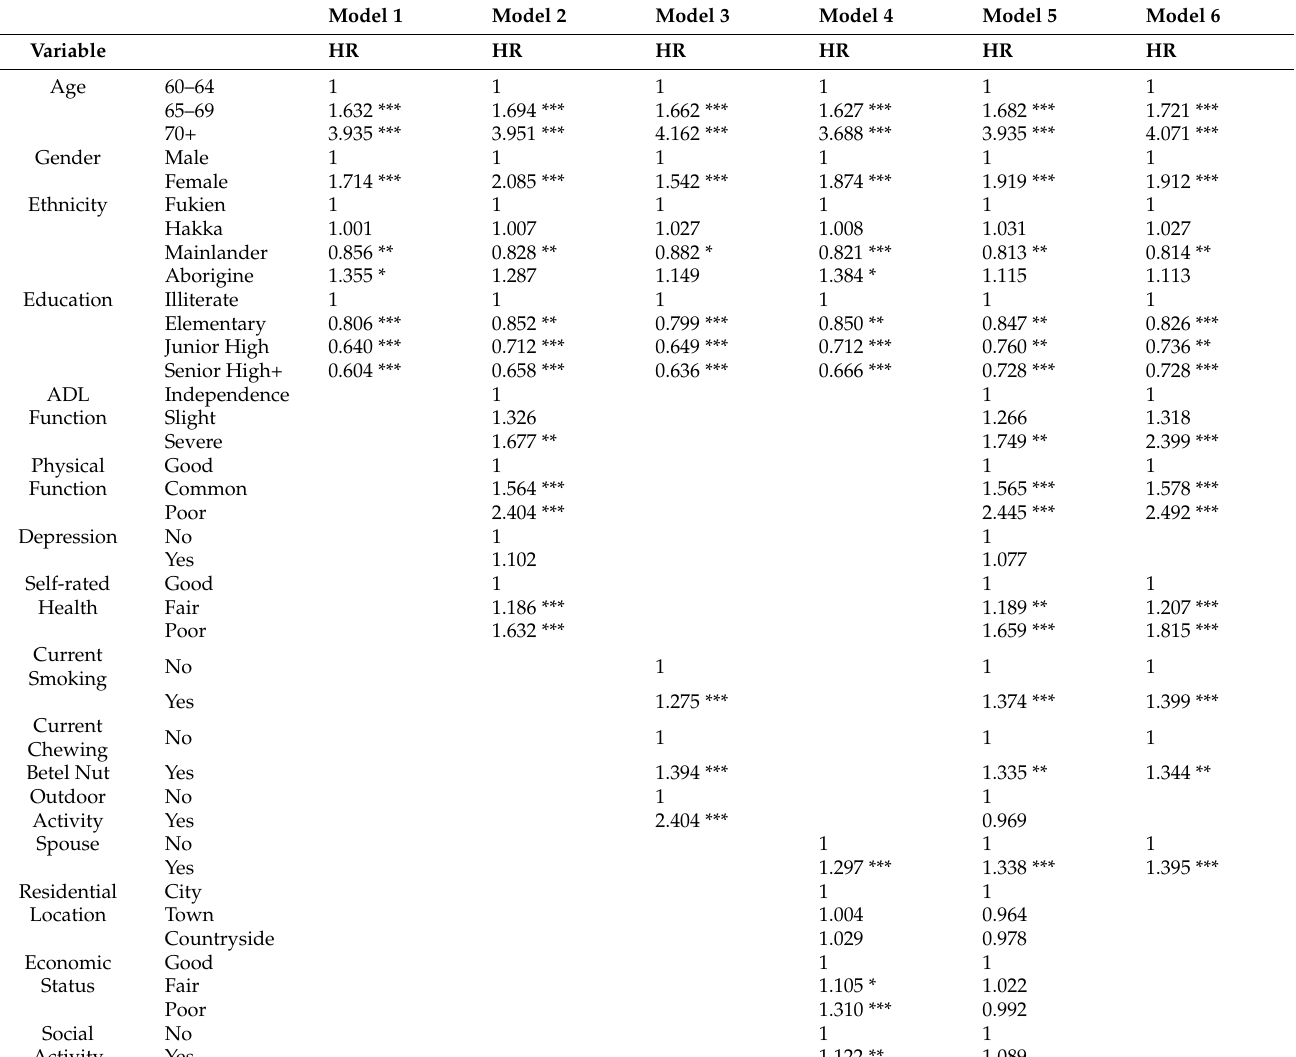
Table 3. Results of Cox proportional frailty hazard